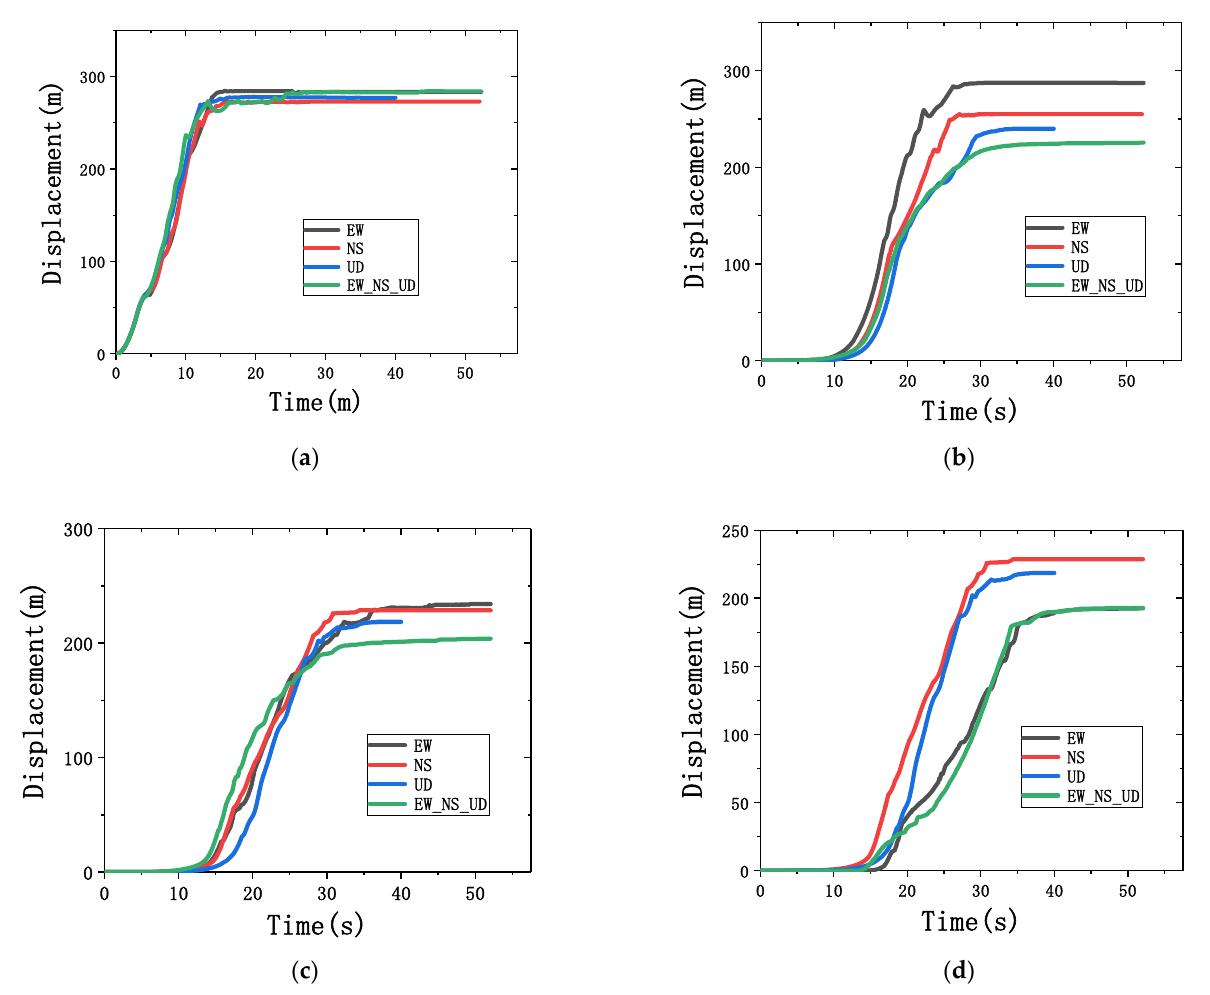
Figure 18. Time history curves of displacement of monitors 3/4/5/6 in four cases. ( a ) Monitor 3; ( b ) Monitor 4; ( c ) Monitor 5; and ( d ) Monitor 6.